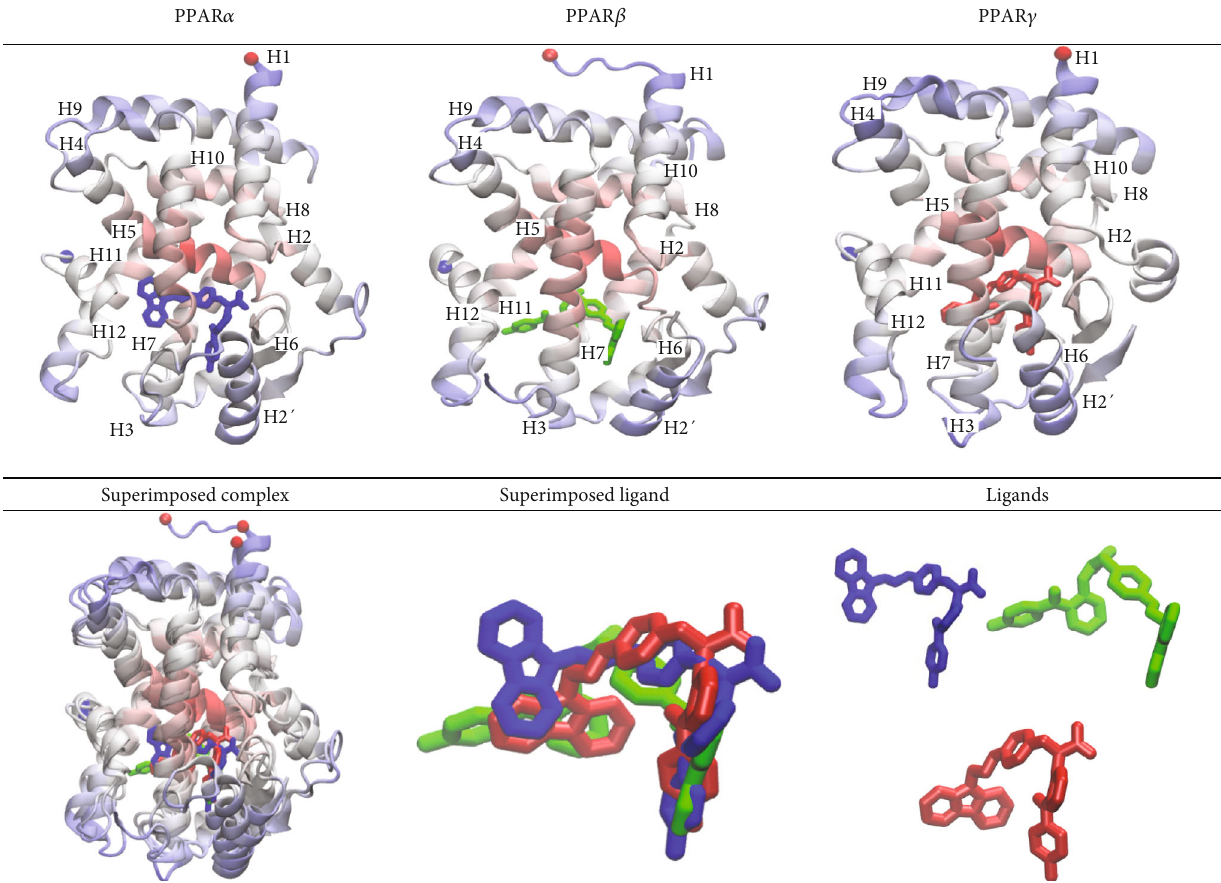
Figure 10: Structural comparison of the most abundant complex structure of each PPAR α (3VI8), PPAR β (3TKM), and PPAR γ (2PRG) including the superimposed complex. Chiglitazar is represented in blue, green, and red for the PPAR α , PPAR β , and PPAR γ complexes, respectively, and each receptor is colored based on mobility where blue is the most mobile and red is the least. Table 1: MM-GBSA binding energies with standard deviation of chiglitazar bound to PPAR α , PPAR β , and PPAR γ receptors. Term PPAR α PPAR β PPAR